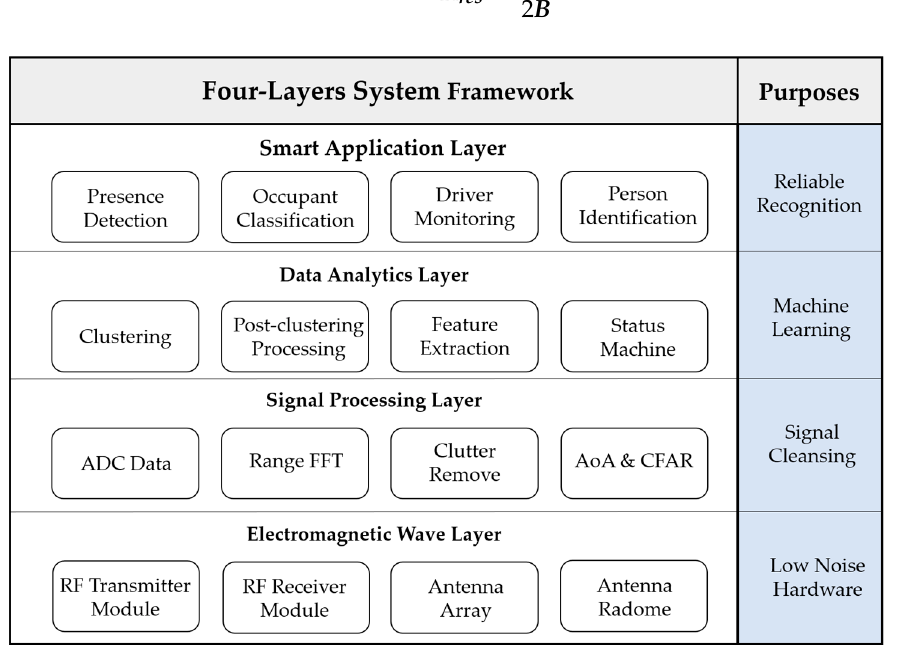
Figure 1. General layered system framework for the in-vehicle occupant monitoring system.